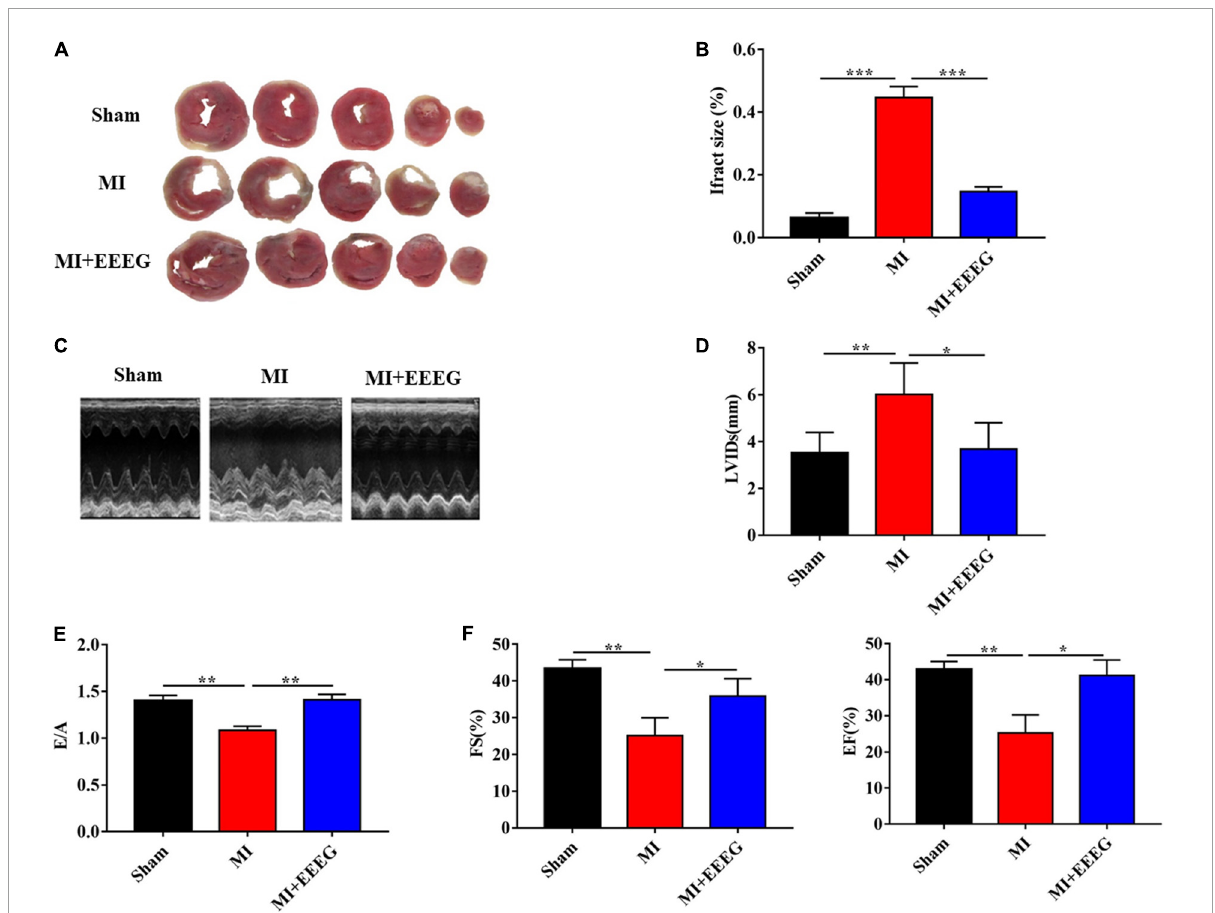
FIGURE1 EG extract (EEEG) reduces infarct area and protects against cardiac dysfunction after MI. (A) Representative TTC staining of cardiac tissue obtained from vehicle and EEEG (10 g/kg) treated rats at 4 weeks after MI or sham operation. (B) Quantitative analysis of TTC-stained infarct area 4 weeks after MI or sham operation in vehicle and EEEG (10 g/kg) treated rats ( n = 8). (C) Representative M-mode tracing for vehicle and EEEG (10 g/kg) treated rats at 4 weeks after MI or sham operation are shown. (D–F) Echocardiographic analysis of left ventricular end-systolic diameter (D) , the ratio of mitral peak velocity during early diastole to atrial contraction (E) , ejection fraction ( F , left panel), and fractional shortening ( F , right panel) at 4 weeks after MI or sham operation in vehicle and EEEG (10 g/kg) treated rats ( n = 8). Data are mean ± SEM. * P < 0.05, ** P < 0.01, *** P <